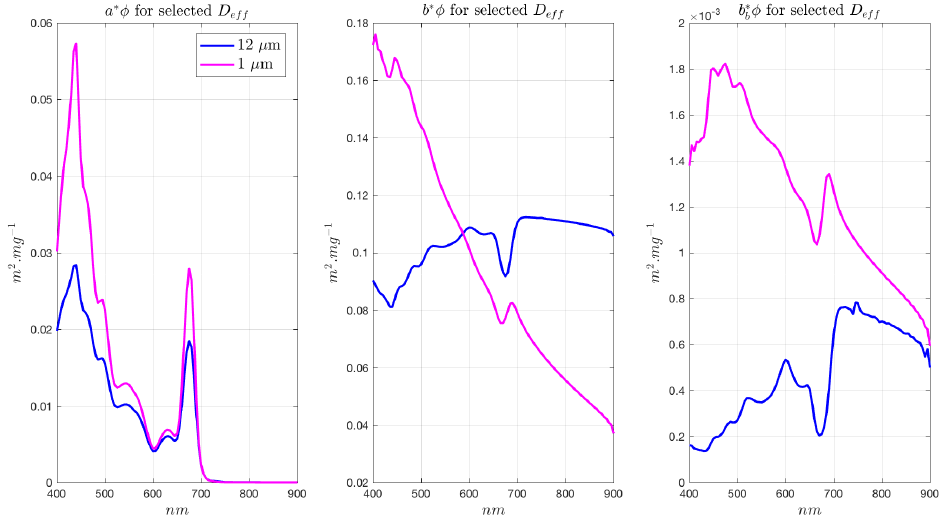
Figure A3. EAP Phycoerythrin-containing IOPs (based on Myrionecta Rubra ), used for cryptophyte-dominated assemblages in the Benguela, and Synechococcus sp. in the Southern